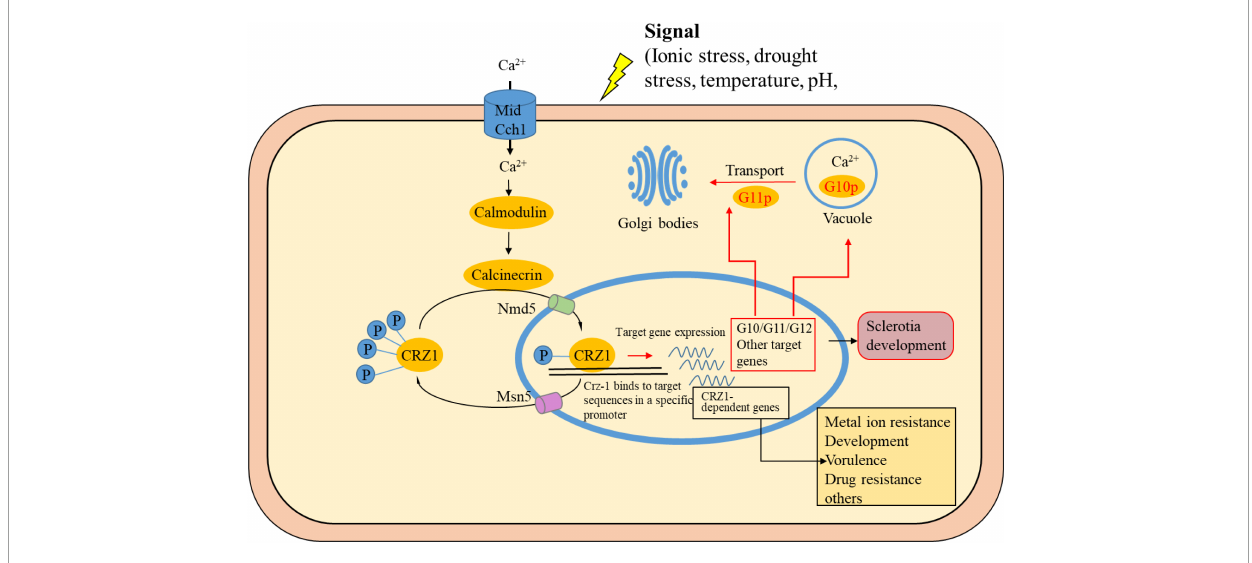
FIGURE7 Schematic representation of CRZ1 and target genes in Ca 2 + pathways. When the cytosolic Ca 2 + concentration increases, calmodulin activates calcineurin, which in turn dephosphorylates CRZ1. CRZ1 is then imported into the nucleus and induces or represses expression of its target genes. After phosphorylation (P), CRZ1 is exported from the nucleus. The cylinders represent channel proteins, and the yellow ovals represent proteins inside the cell. Genes in the black box are those reported in the literature (Thewes, 2014). Genes in this study are marked in red boxes or red